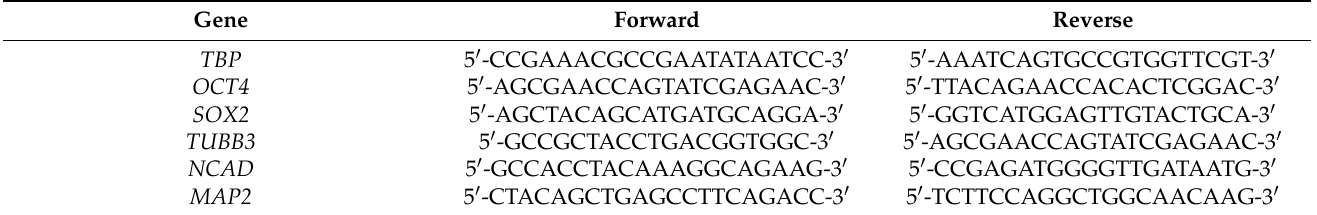
Table 1. Primers used for RT-qPCR experiments. The annealing temperature for all primers is 62 ◦ C.